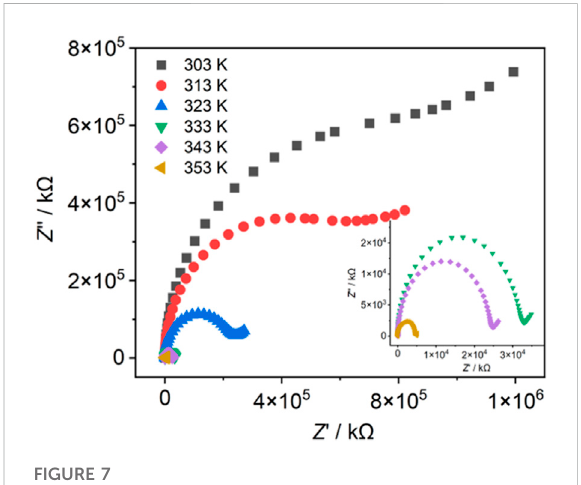
FIGURE 7 Nyquist plots of Dy-CP measured at 30% RH and indicated